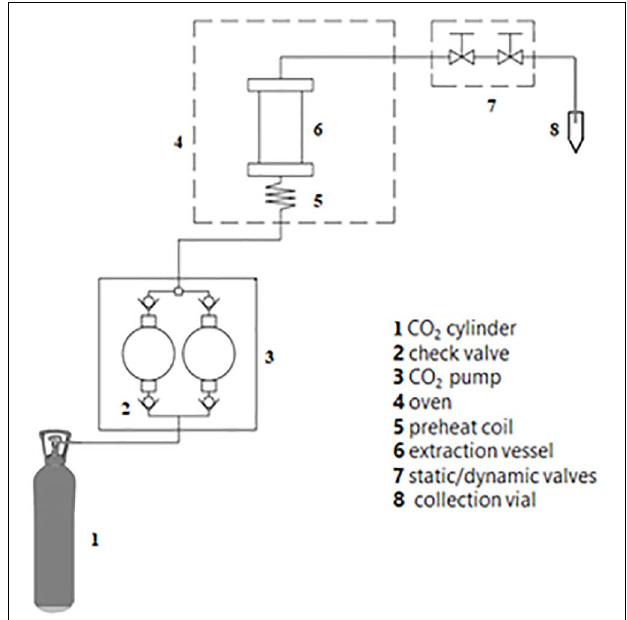
FIGURE 1 | Schematic flow diagram of supercritical CO 2